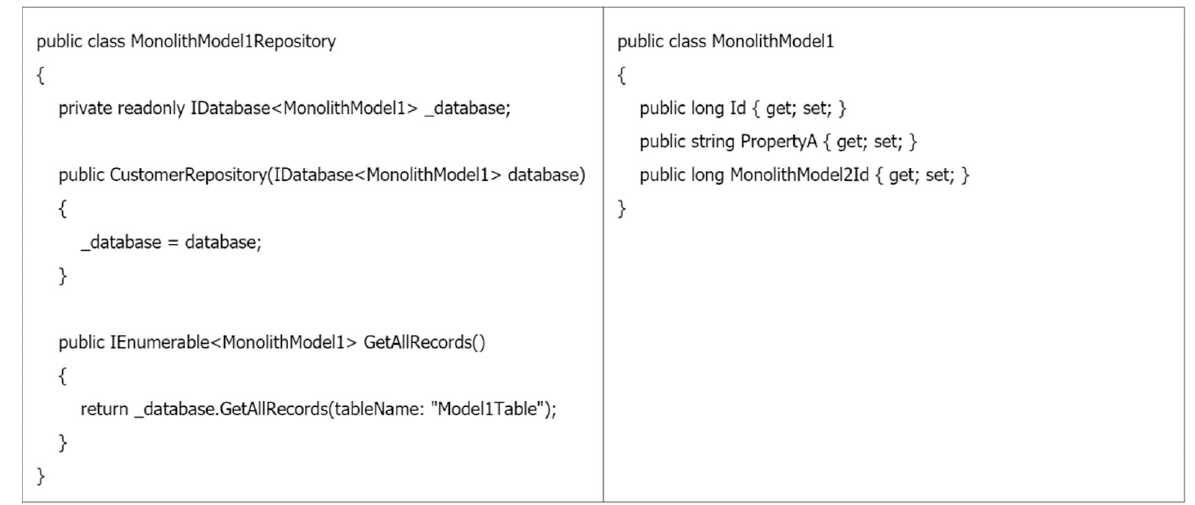
Figure 6. An example of the simplified repository and model implementations.